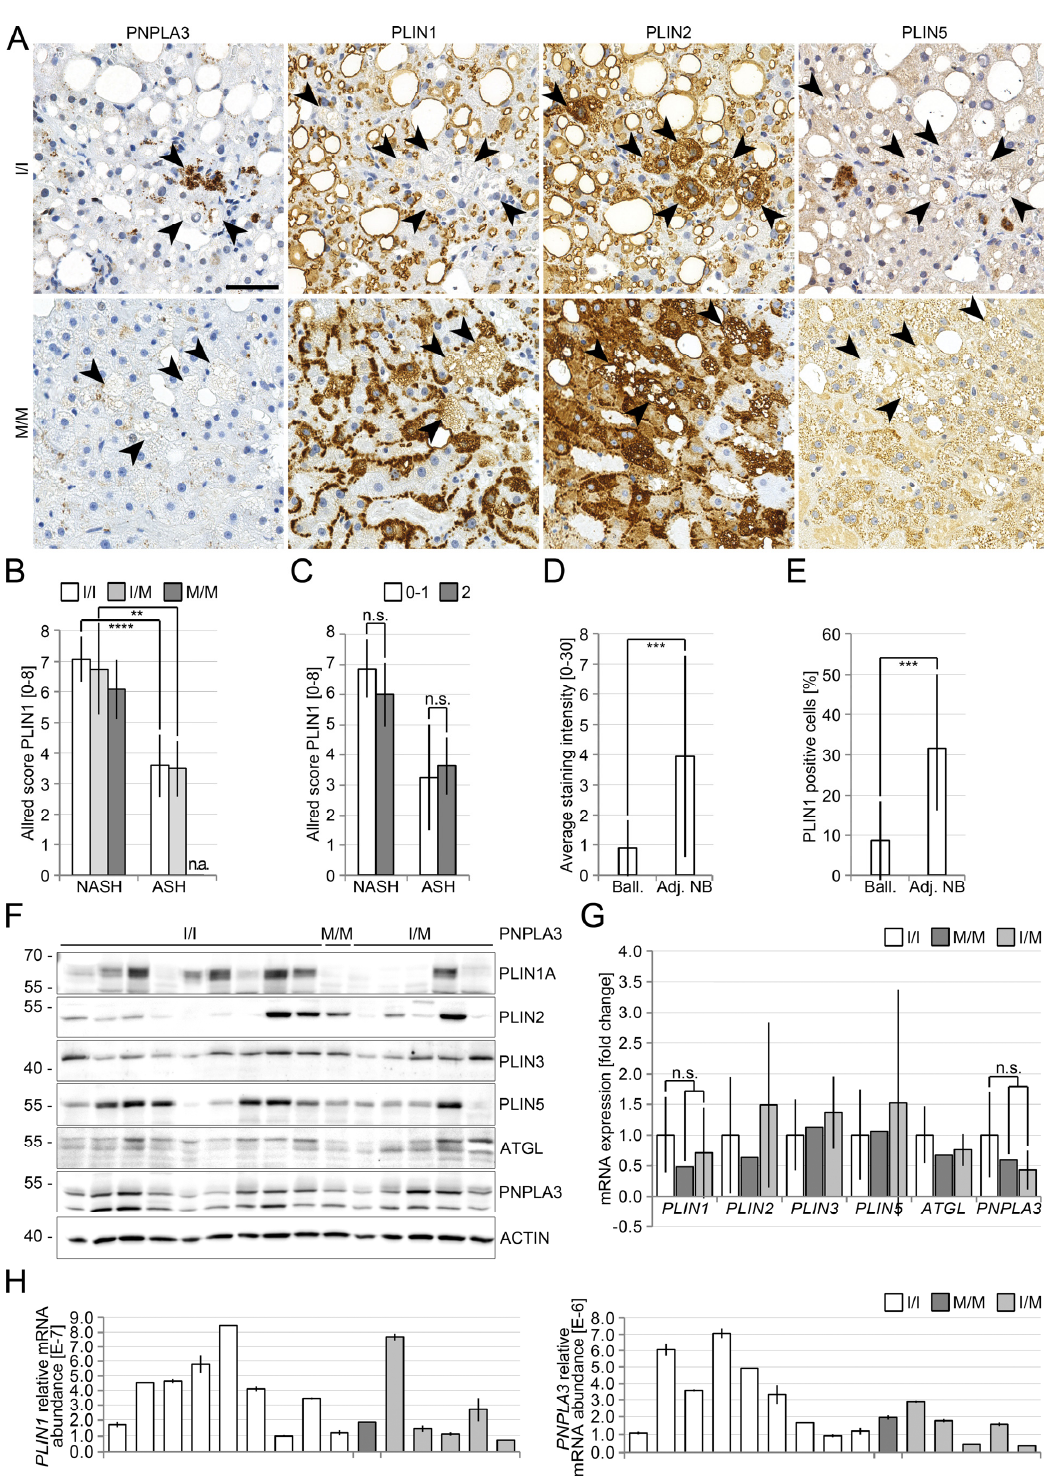
Figure 2. Expression pattern of PNPLA3 and perilipins in ballooned hepatocytes in ASH and NASH livers in situ. ( A ) Immunohistochemical analysis of PNPLA3, perilipin 1, 2 and 5 in ballooned hepatocytes (arrowheads) of either PNPLA3 I/I-or PNPLA3 M/M-carriers with NASH. Perilipin 1